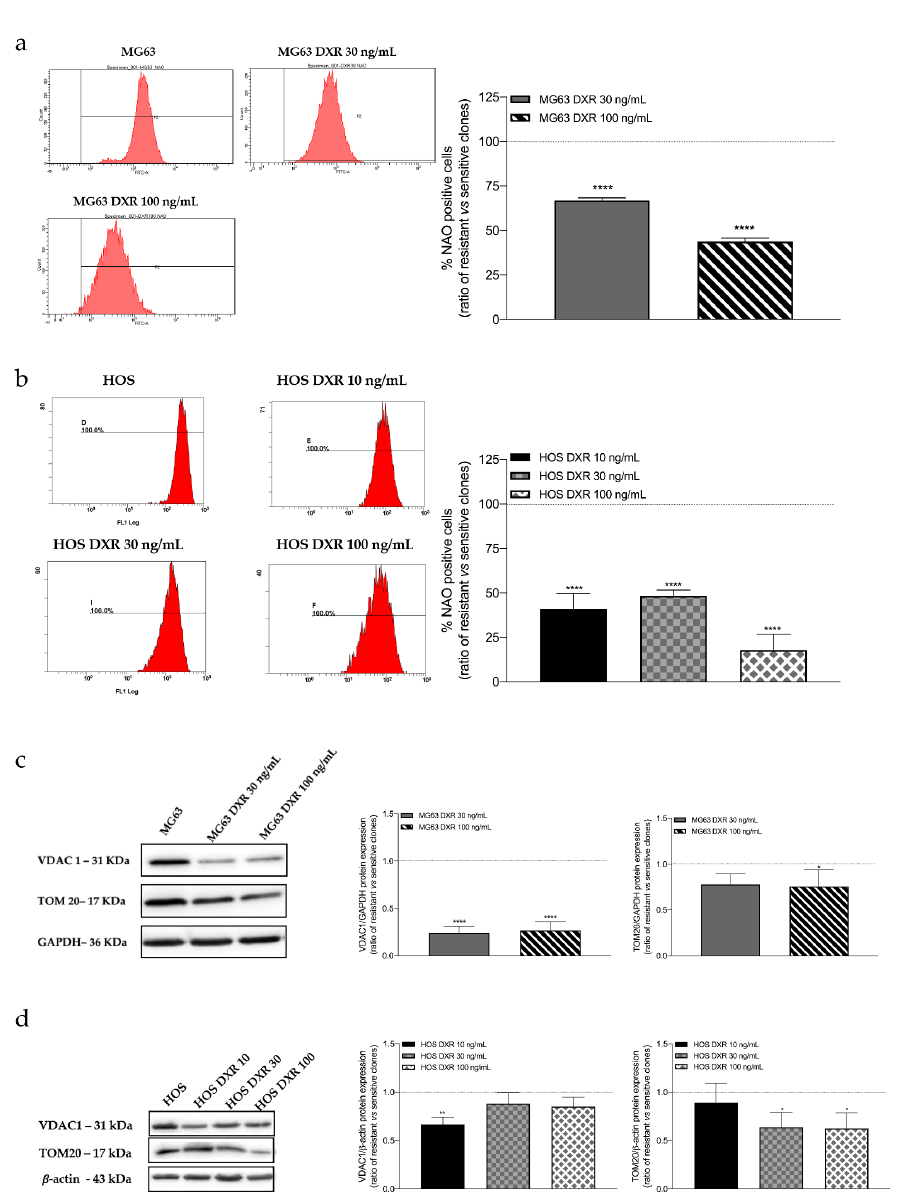
Figure 2. Evaluation of mitochondrial mass by flow cytometry and western blot. ( a ) Representative cytograms and graphical representation showing the percentage of fluorescence intensity of NAO 1.25 µ M in MG63, MG63 DXR 30 ng/mL, and MG63 DXR 100 ng/mL cells. The horizontal dotted line refers to normalized untreated cells. ( b ) Representative cytograms and graphical representation showing the percentage of fluorescence intensity of NAO 1.25 µ M in HOS, HOS DXR 10 ng/mL, HOS DXR 30 ng/mL, HOS DXR 100 ng/mL cells. The horizontal dotted line refers to normalized untreated cells. Data represent mean ± SD of three different experiments. **** p < 0.0001, resistant vs. sensitive cells. ( c ) Representative images and graphical quantification of protein expression of VDAC1 and TOM20, normalized to GAPDH in MG63, MG63 DXR 30 ng/mL, and MG63 DXR 100 ng/mL cells. The horizontal dotted line refers to normalized untreated cells. ( d ) Representative images and graphical quantification of protein expression of VDAC1 and TOM20, normalized to β -actin in HOS, HOS DXR 10 ng/mL, HOS DXR 30 ng/mL, HOS DXR 100 ng/mL cells. The horizontal dotted line refers to normalized untreated cells. The uncropped Western Blot images can be found in Figure S2. Data represent mean ± SD of four different experiments. * p < 0.05, ** p < 0.01, **** p < 0.0001, resistant vs. sensitive